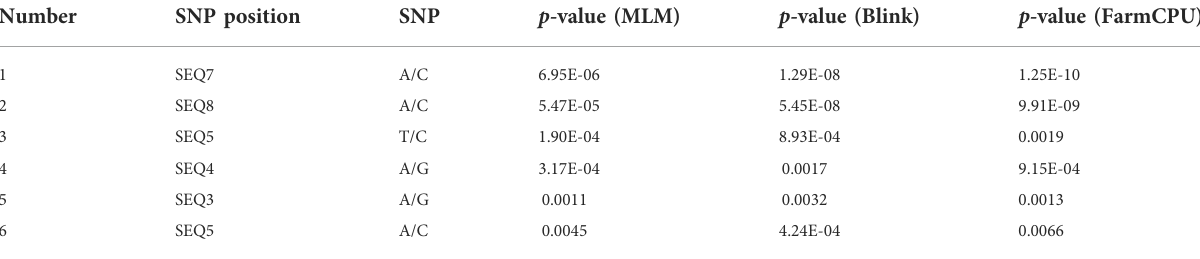
TABLE 2 Markers associated with ammonia nitrogen tolerance of L . vannamei